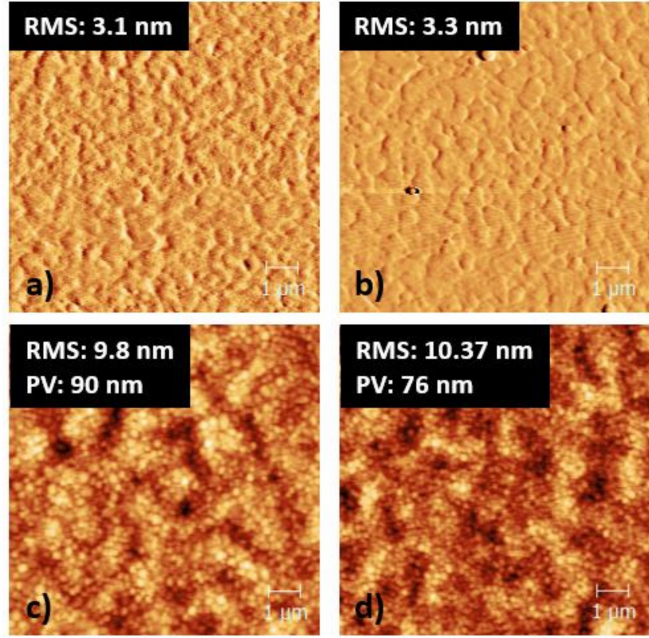
Figure 1. AFM images of ( a ) phase contrast of quartz / Cu:NiOx, ( b ) phase contrast of quartz / Cu:NiOx / β -alanine, ( c ) topography of ITO / Cu:NiOx / Perovskite, and ( d ) topography of ITO / Cu:NiOx / β -alanine / Perovskite.